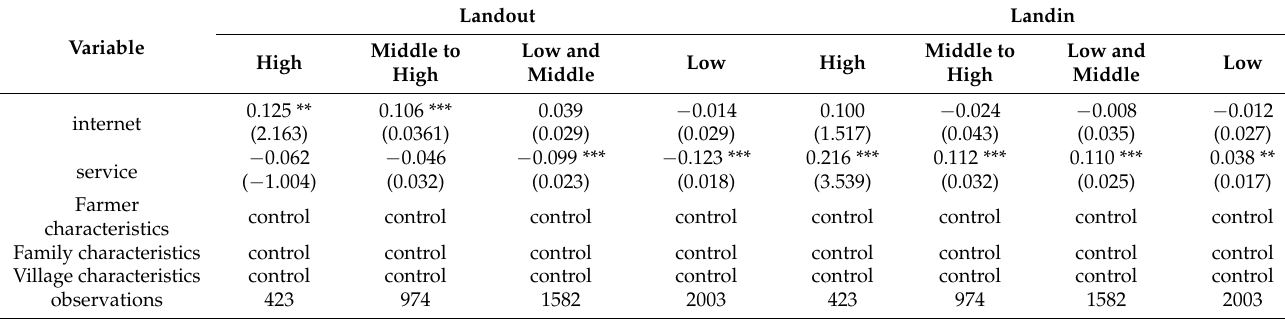
Table 3. Heterogeneity Analysis of Farmers Grouped by Income.